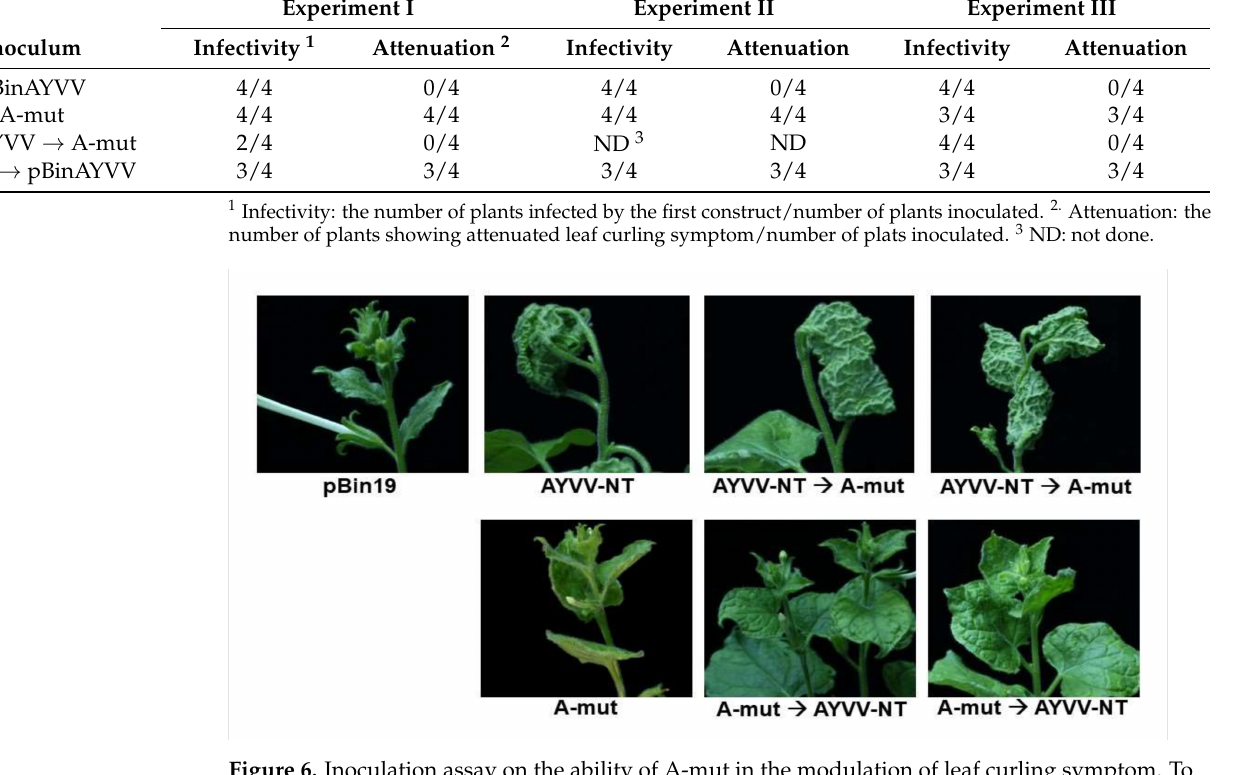
Figure 6. Inoculation assay on the ability of A-mut in the modulation of leaf curling symptom.